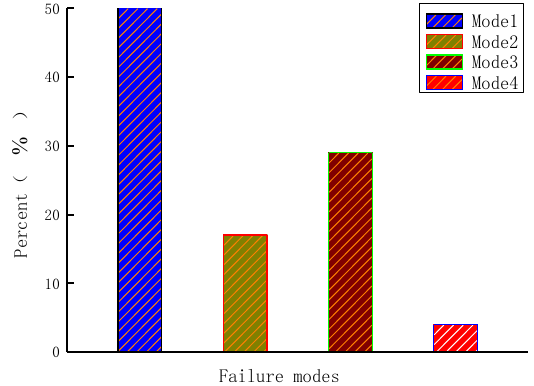
Figure 9. Percentage of different failure modes.